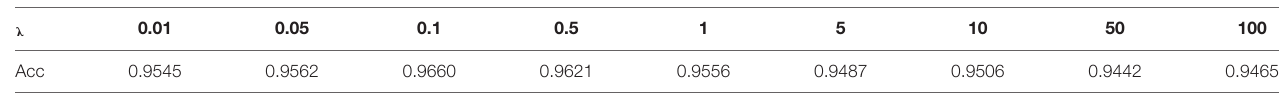
TABLE 4 | The influence of λ value on accuracy.